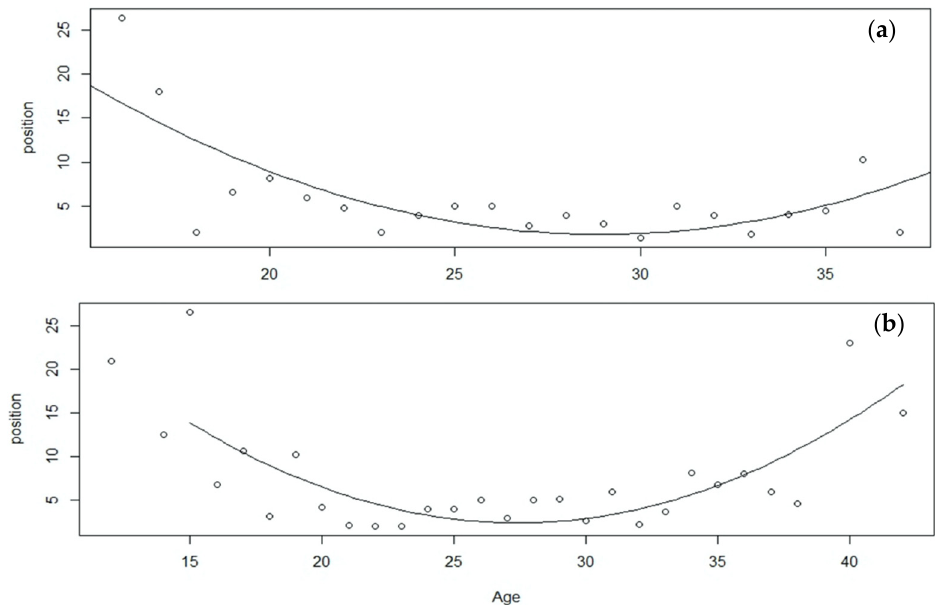
Figure 3. Quadratic models of the top 10th percentile of men ( a ) and women ( b ) participants in the 10-km races of the WCH and OG since 2000.